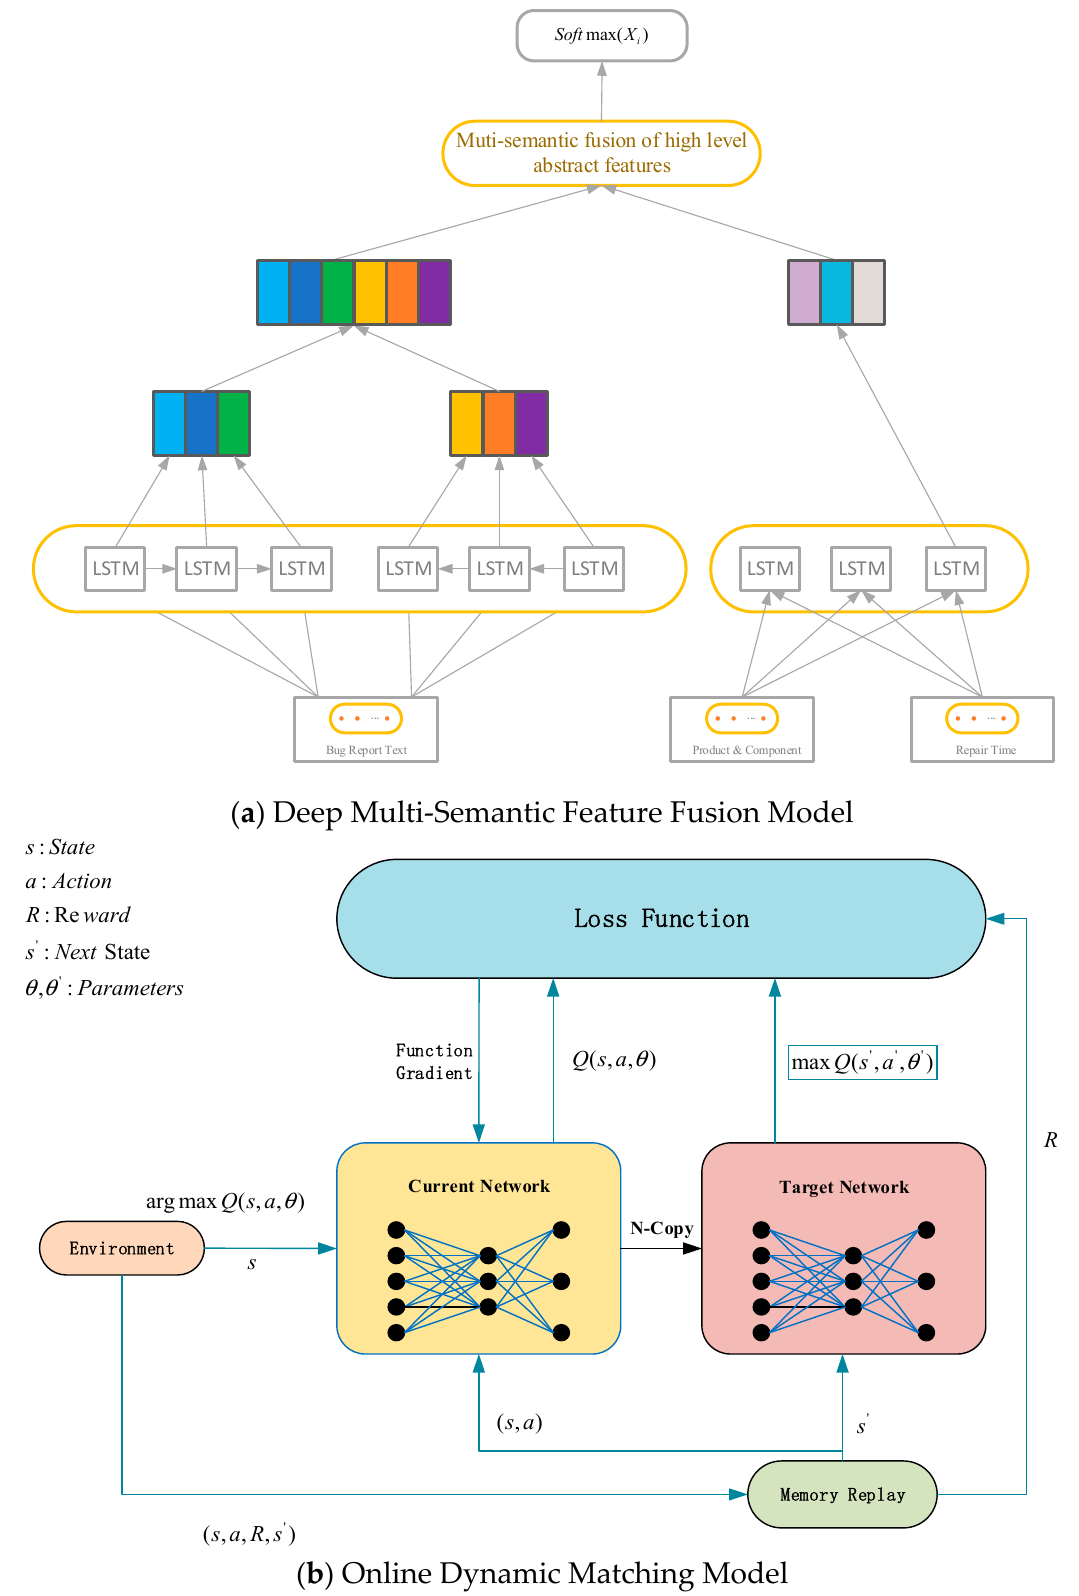
Figure 3. The framework of